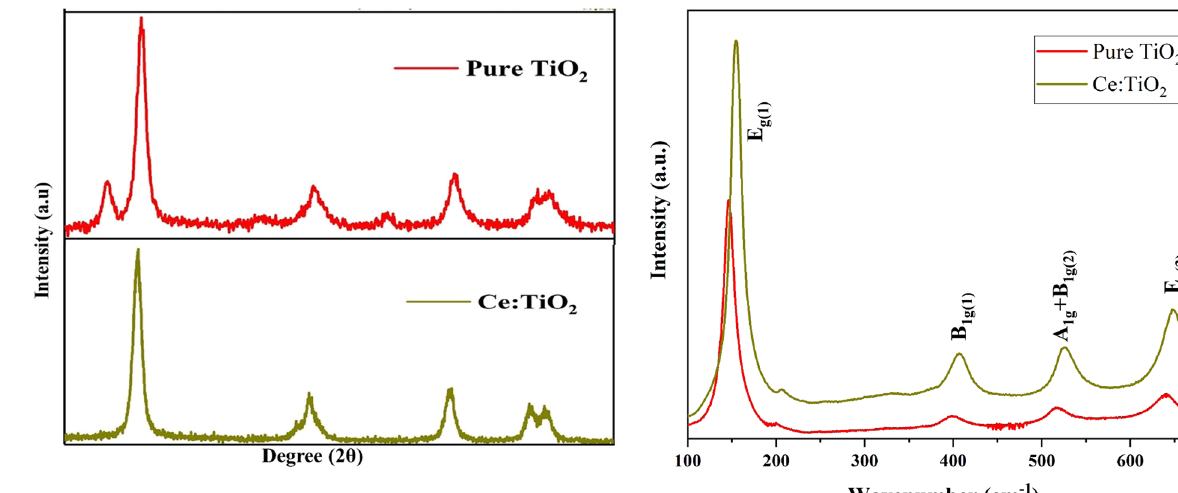
Figure 1: X - ray di ff raction analysis of pure and Ce - doped TiO 2 nanoparticles.